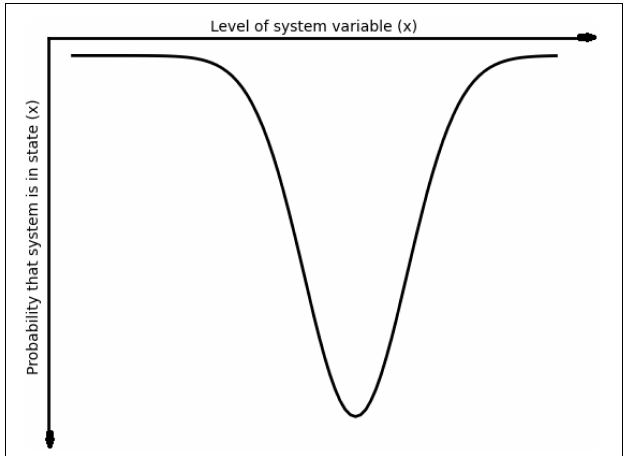
FIGURE 2 | The solid line shows a shallow and wide basin of attraction, representing a system with more pronounced chaotic process (and reduced deterministic process) while the dotted line represents a system with less chaotic process and a more pronounced deterministic basin of